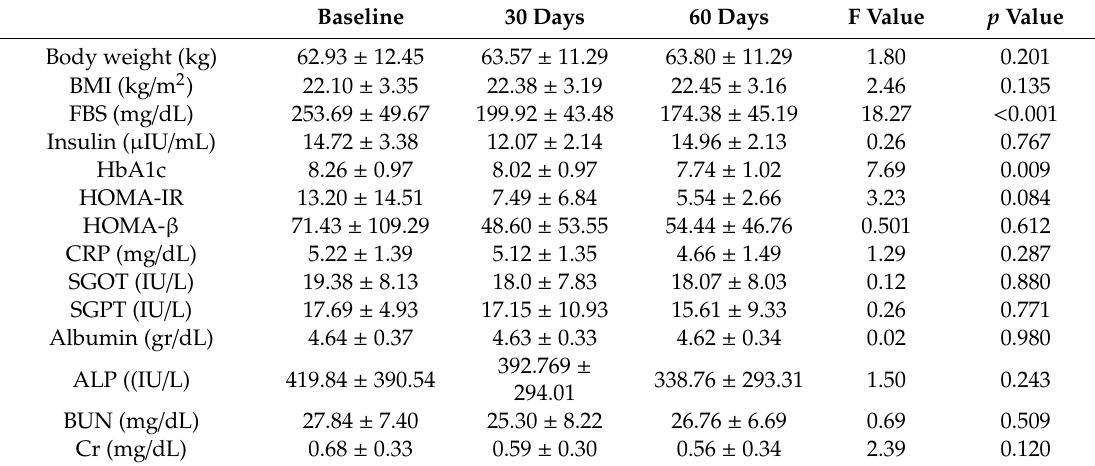
Table 1. Anthropometric and biochemical parameters in patients with type 1 diabetes (T1D) mellitus before and after resveratrol supplementation. Data is presented as means ± SD; BMI: Body